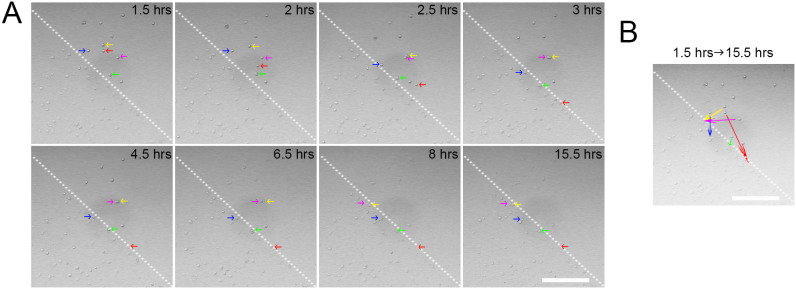
Scratched area attracted colonies of microglia.(a) Time-lapse live cell imaging showed the migration of microglia (depicted by arrows with different colors) from the non-scratched area to the scratched area. (b) Simplified migratory paths of the microglia from 1.5 hours to 15.5 hours after cell seeding. Scale bars: 250 μm.